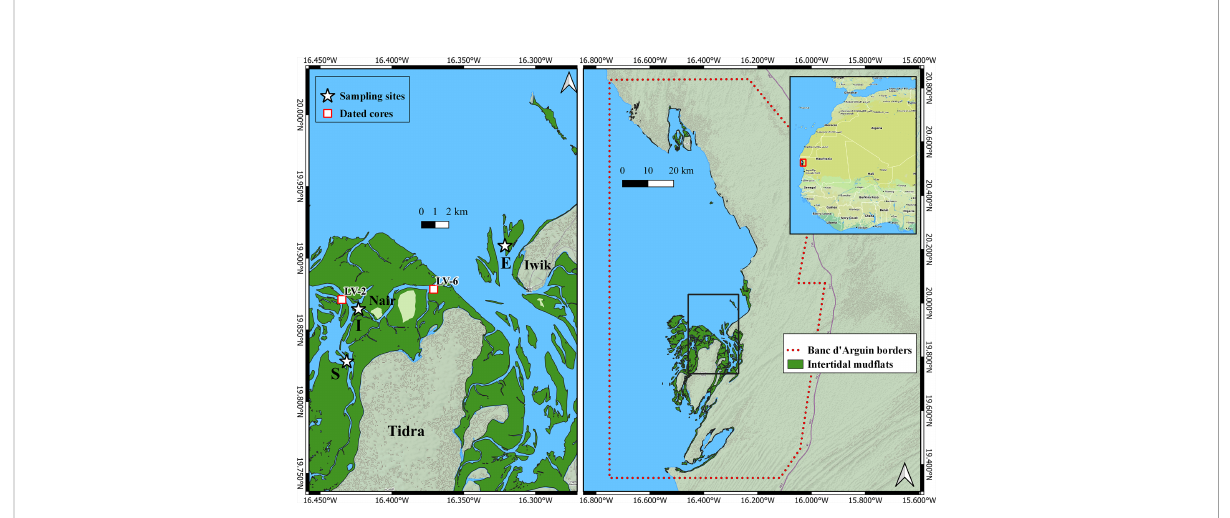
FIGURE 1 Map of the Parc National du Banc d ’ Arguin, Mauritania, with sampling locations: black stars indicate where cores were taken for carbon, diatom and geochemical analyses; while red squares represent site where dated cores were previously taken. The sampling sites represent three distinct wave action regimes: E = Exposed (19°54 ′ 34 ″ N, 16°19 ′ 10 ″ W), I = Intermediate (19°51 ′ 52 ″ N, 16°25 ′ 26 ″ W) and S = Sheltered (19°49 ′ 39 ″ N, 16° 25 ′ 54 ″ W) (El-Hacen et al.,